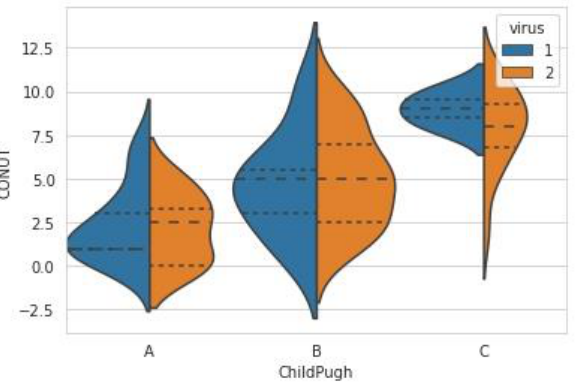
Figure 2. The CONUT scores according to Child–Pugh classification (1—virally induced liver cirrhosis, 2 = alcohol-induced liver cirrhosis).